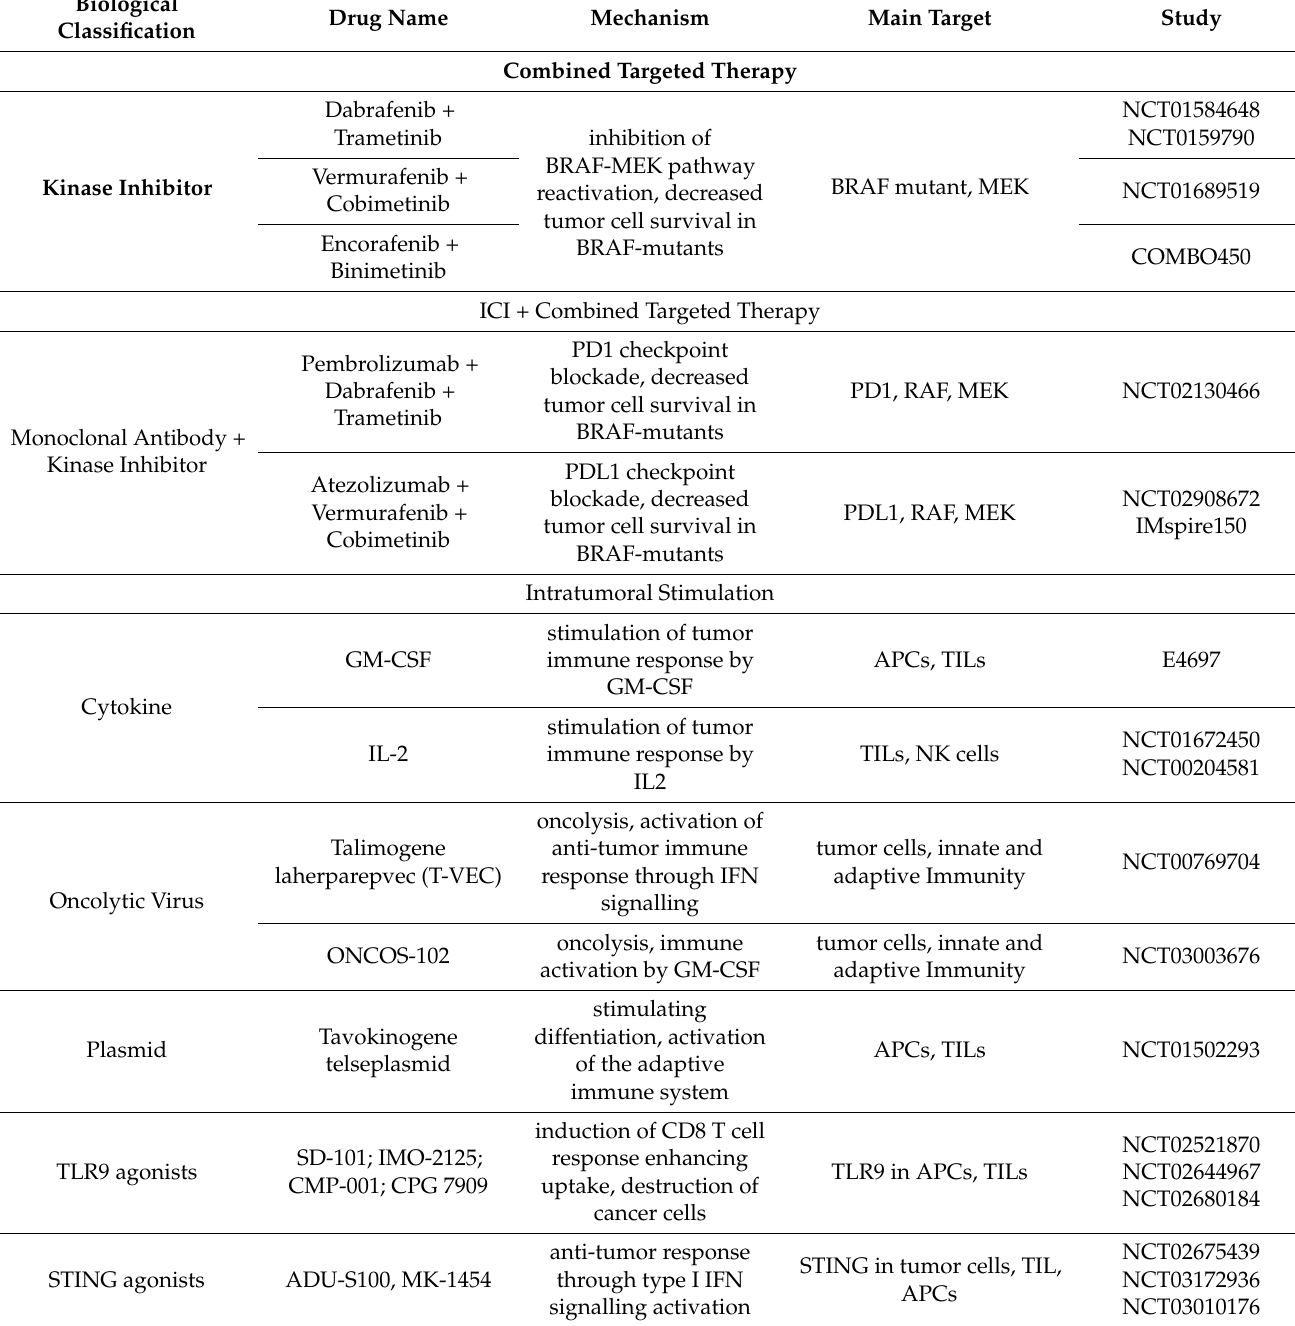
Table 2. Combinational treatment strategies for